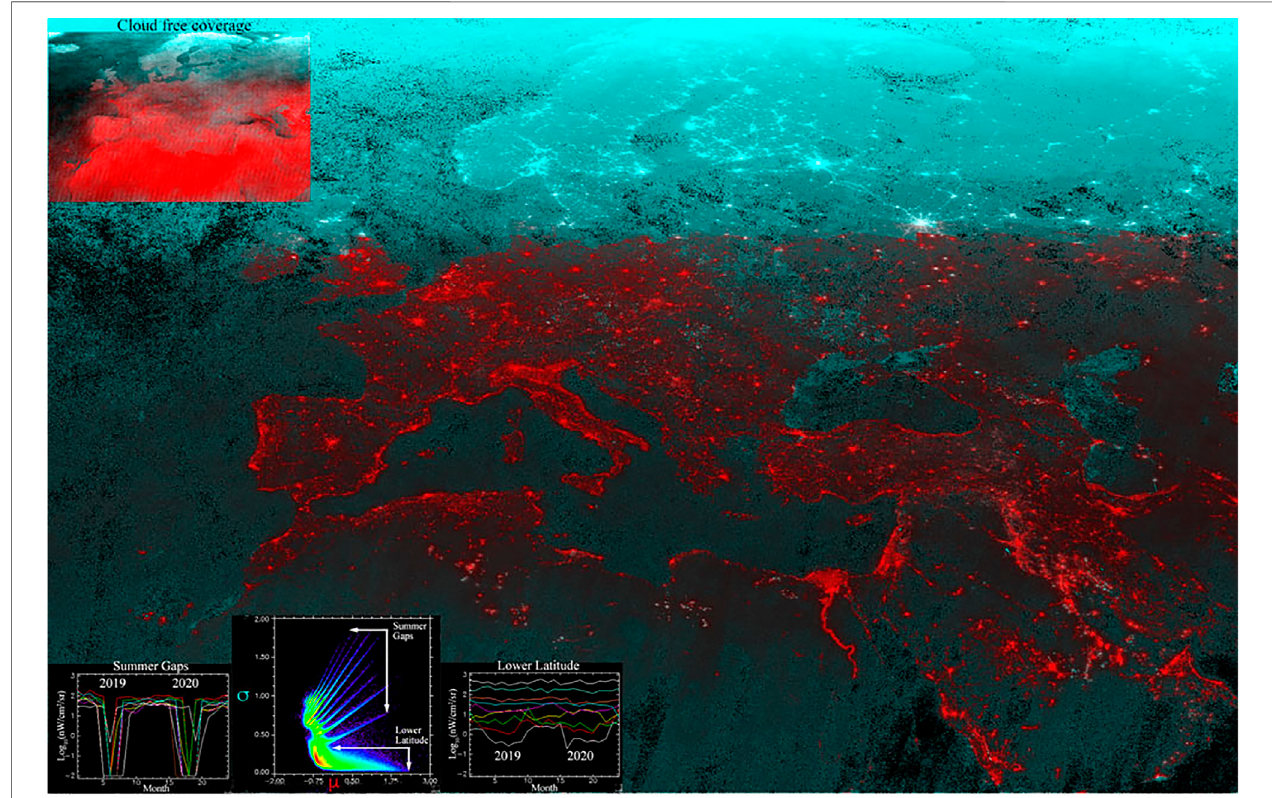
FIGURE 1 | (A) Spatiotemporal moments for Log 10 VIIRS monthly radiance for 2019 + 2020. Mean ( μ ) monthly Log 10 radiance (red) is consistently high for lighted development and relatively low elsewhere, while the standard deviation ( σ ) of monthly Log 10 radiance (cyan) is low for lighted development and relatively high elsewhere. Lighted development at higher latitudes has high μ and σ so appears white. The μ vs σ distribution (inset scatterplot) shows spurs of rapidly increasing σ with μ for high latitude coverage gaps in summer months. Individual spurs of increasing μ and σ on the upper limb of the scatterplot correspond to brighter sources with different summer gap lengths (inset left) . Monotonicallydecreasing range of σ for μ > 1 nW/cm 2 /sr on thelowest limb ofthe distribution results from increasingtemporal stability (decreasing σ ) with increasing brightness for sources south of the summer gap latitudes (inset right) . Gas fl ares at all latitudes are both bright and variable (white). Inset map of μ and σ for cloud free acquisitions per month for 2019 + 2020 (top) shows a similar pattern as a result of both cloud cover and high latitude coverage gaps.